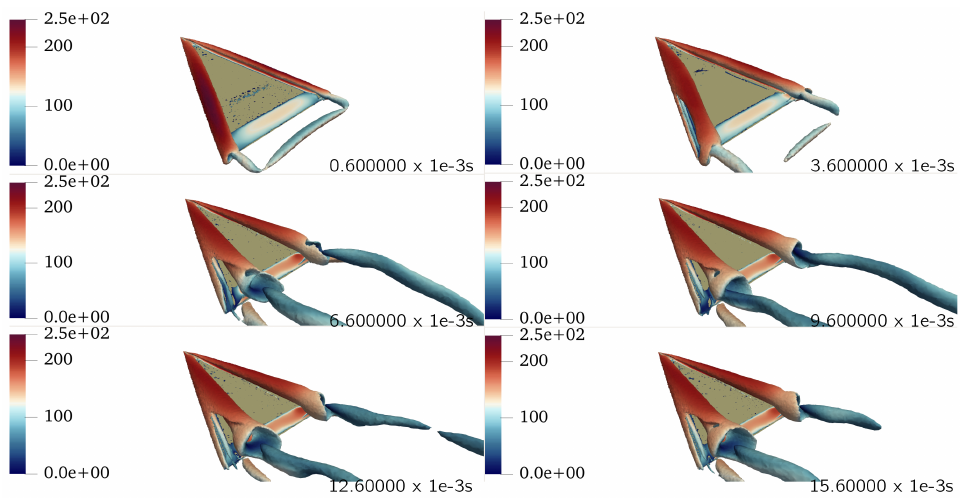
Figure 11. Contours of the Q-criterion Q = 800s − 2 coloured with the velocity magnitude for different time instants, delta wing test